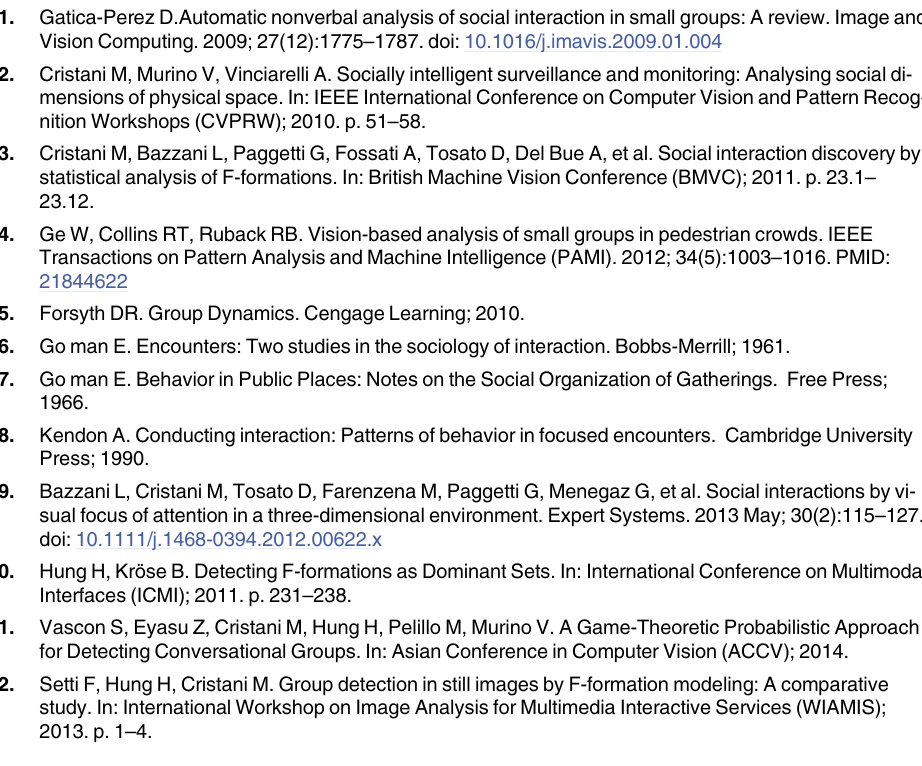
Algorithm 1. is based on a graph-cuts minimization scheme, which essentially clusters